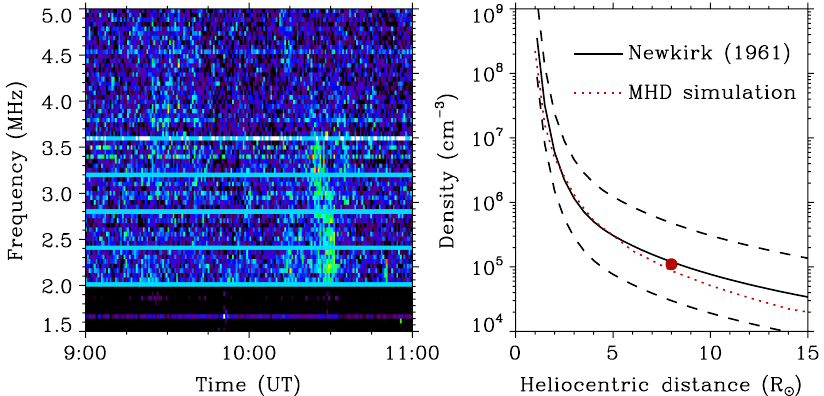
FIG. 4. Left: The observed type-III-like radio burst from STEREO-A. The starting frequency is approximately 3 : 7 MHz at around 10:24. The ending frequency is not well discerned because there is no coverage of frequencies below 2 MHz. Right: Density of solar atmosphere as a function of height. The solid line is from the Newkirk model, with the two dashed lines enclosing it representing four- fold and one-quarter of the model value, respectively. The red dotted line is a realtime MHD calculation obtained using the Predictive Science STEREO modeling web site [46]. The red dot has a density of 10 5 cm (cid:1) 3 , corresponding to a frequency of approximately 3 MHz , and a height of 8 R (cid:2) . These numbers agree with the location of the merged blob at